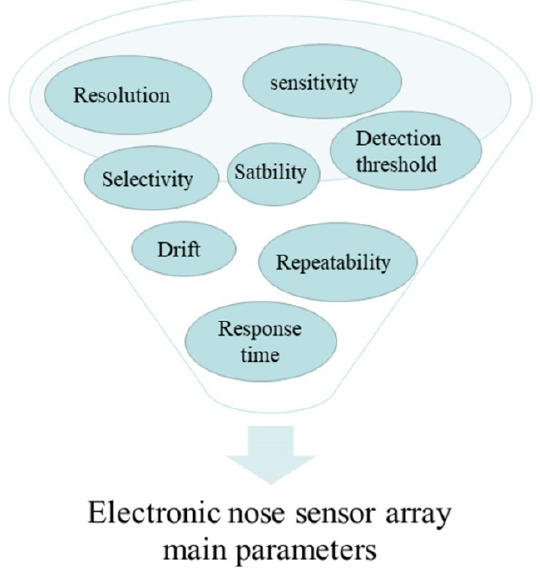
Figure 2. Electronic nose sensor array main parameters.